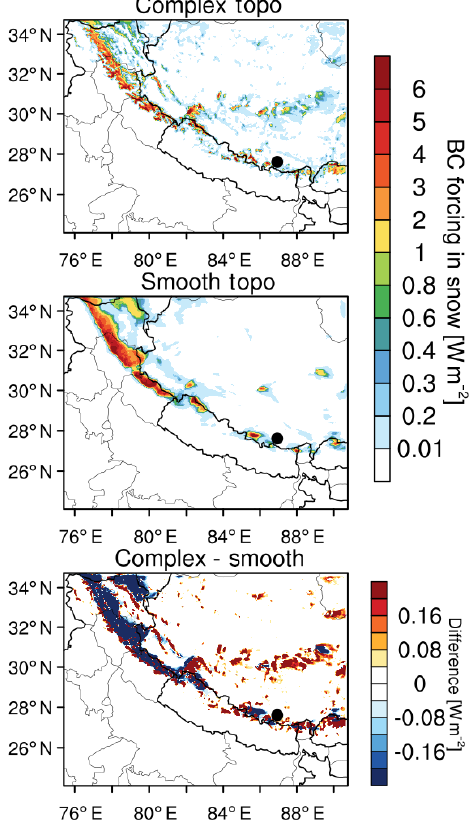
Figure 16. Spatial distributions of snow water equivalent averaged for 1–20 April 2016 from the simulations with the complex and smooth topographies. The difference between the two is also shown.